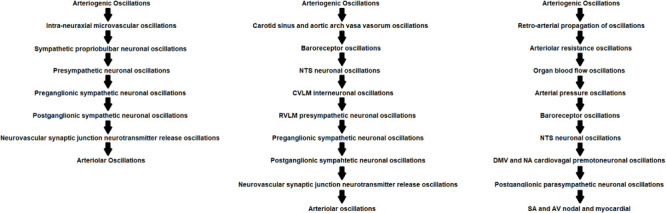
Neuronal-vascular interactions may generate Mayer waves. CVLM, caudal ventrolateral medulla; DMV, dorsal motor nucleus of the vagus; RVLM, rostral ventrolateral medulla; NA, nucleus ambiguus; NTS, nucleus tractus solitarius.